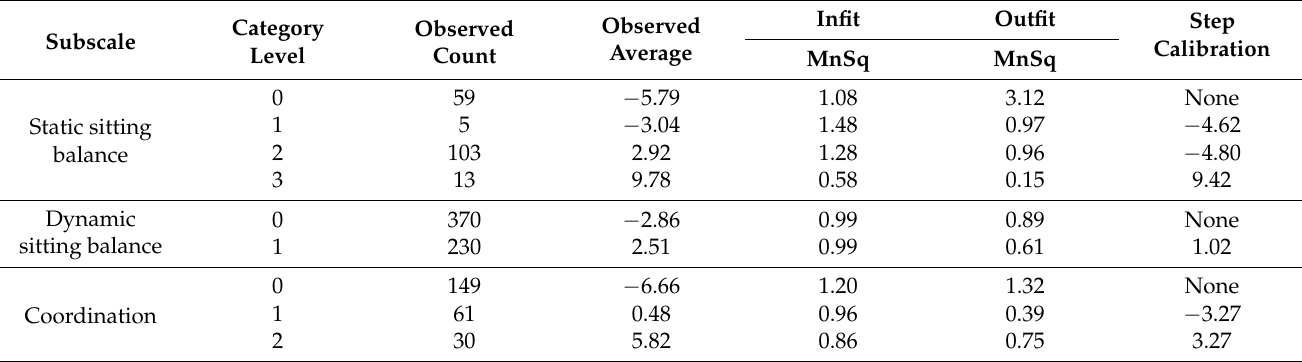
Table 4. Summary of the rating scale analysis of the TIS.